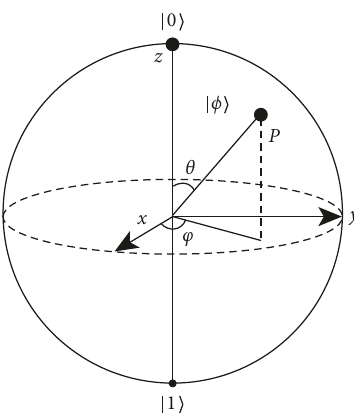
Figure 2: Bloch sphere representation of quantum